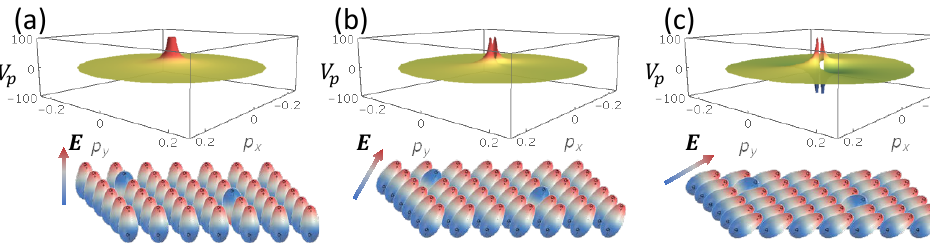
Figure 11: Illustration of the spectral divergence and the localization at a < d ( a ) , and for (a) the isotropic, β = 0, (b) anisotropic localized, 0 < β < β AT ( a ) , cases. The top panel shows the one- or (c) anisotropic delocalized, β > β AT two-sided divergence of the spectrum, while the bottom illustration shows the tilt of the 2d dipolar system in the strong electric